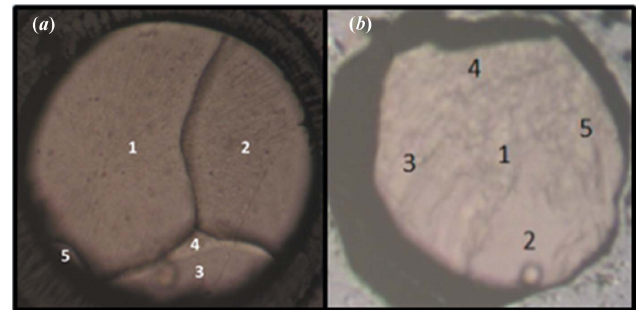
Figure 1 Images of the in situ single crystals: ( a ) phase III at 1.69 GPa, and ( b ) phase II at 1.09 GPa. The diameter of the gasket hole is 350 m m in ( a ) and 260 m m in ( b